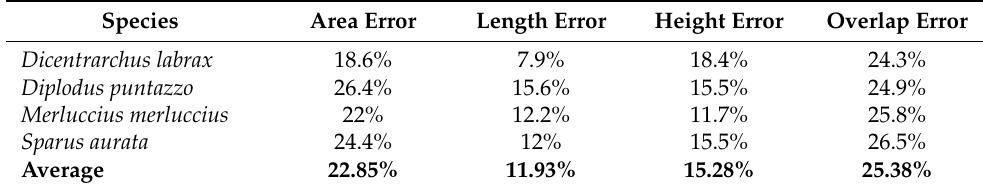
Table 2. Dimension errors for the deep learning BMA approach described in Figure